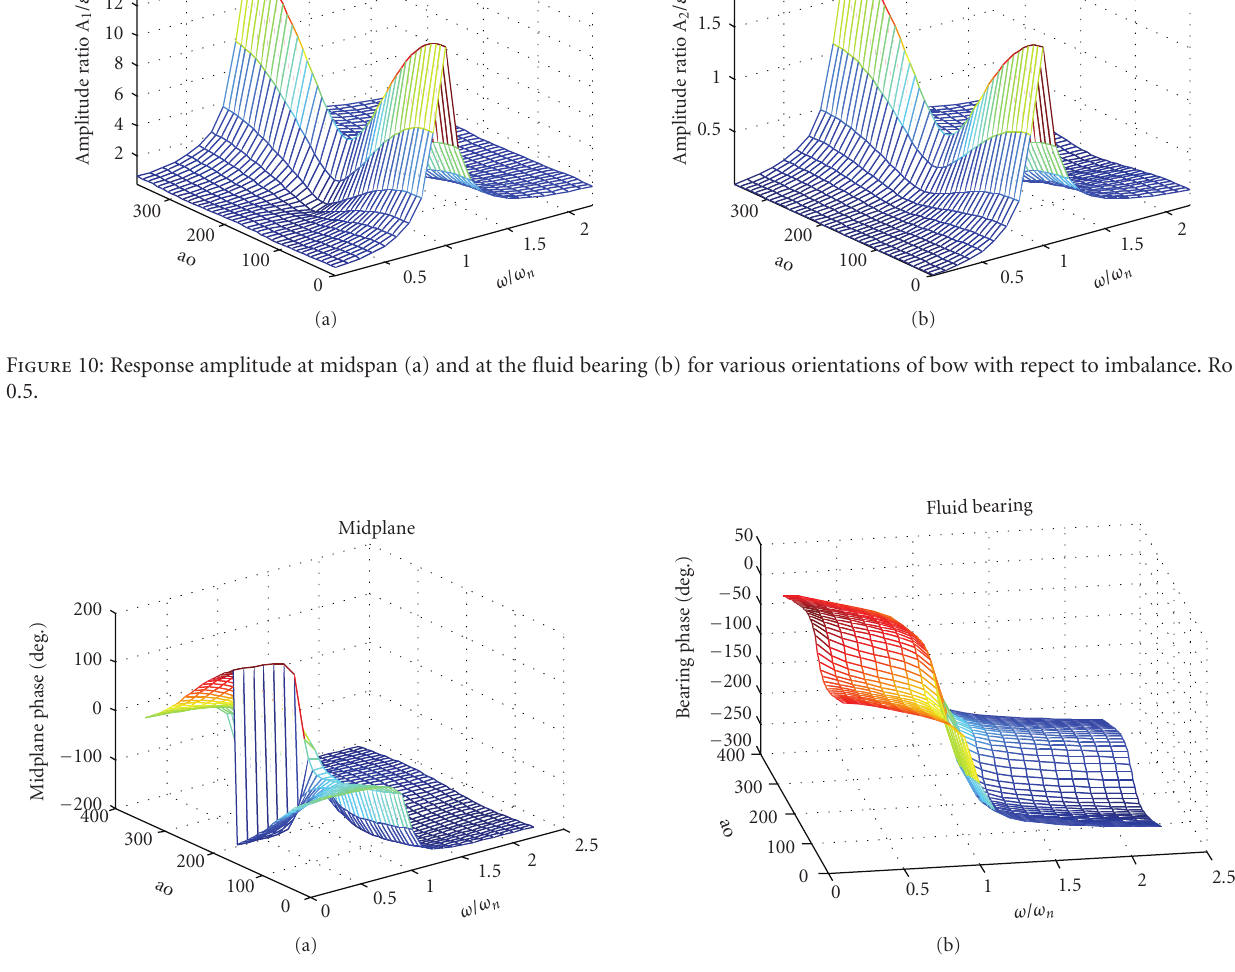
Figure 11: Phase at midspan (a) and at the fluid bearing (b) for various orientations of bow with respect to imbalance. Ro =